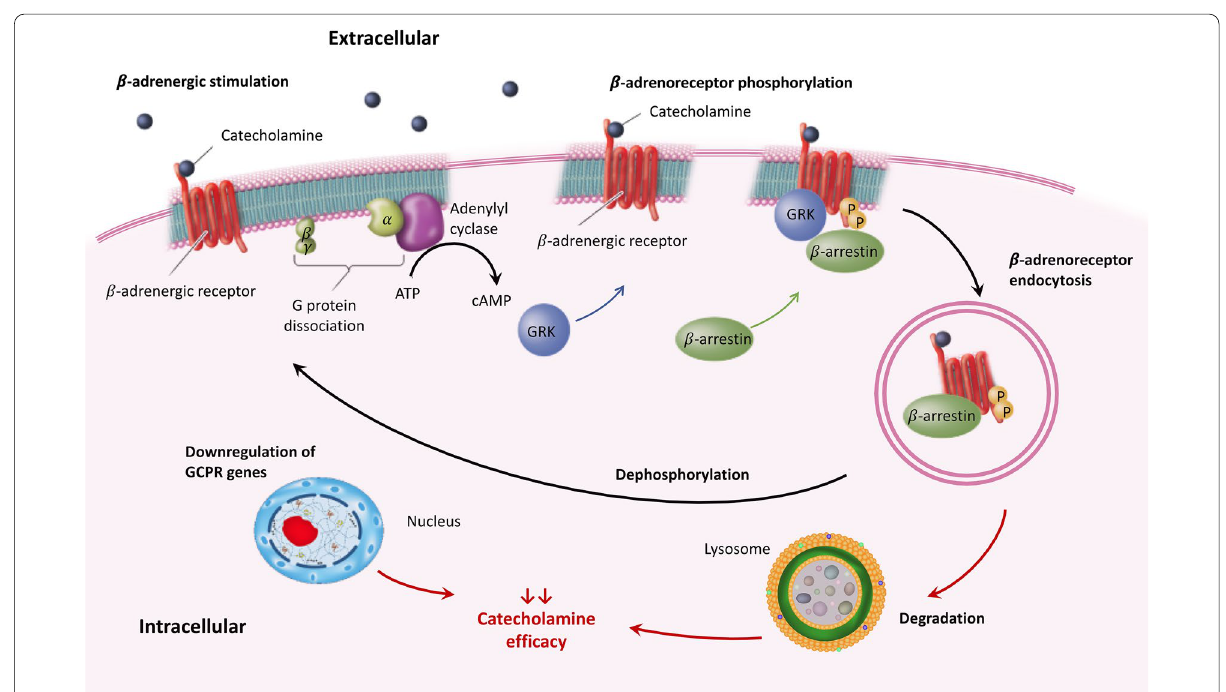
Fig. 2 Mechanisms of adrenergic receptor activation and desensitization (here, β-adrenergic receptor). When catecholamines bind to G protein-coupled receptors (GPCR), there is a conformational change leading to dissociation of the receptors’ G protein subunits and transformation of ATP into cyclic adenosine monophosphate (cAMP). GPCR kinases (GRK) phosphorylate GPCR but only in their agonist-occupied receptor configuration. This GPCR phosphorylation by GRK enhances GPCR interaction with cytosolic proteins known as β-arrestins. These later bind to the GPCR and prevent further intracellular G-protein signaling, preventing the subsequent production of more cAMP. Increased GRK activity forces the equilibrium of β-receptors towards an inactive state. Moreover, β-arrestins promote GPCR internalization and their subsequent degradation in lysosomes. Resensitization is the process that restores the responsiveness of the desensitized receptors, through dephosphorylation by specific phosphatases and receptor recycling back to the cell membrane. Downregulation of genes encoding GPCRs also leads to reduced catecholamine efficacy, through a net loss of receptors. Of note, catecholamine binding modulates a complex cascade of enzymes and transmembrane ion channel activation, all of which are also prone to acute alteration and dysregulation due to sepsis